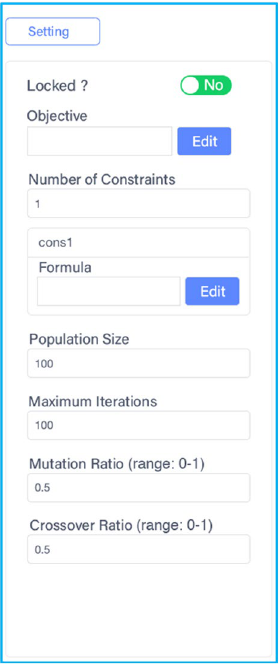
Figure 11 The parameter configuration pane of the GA